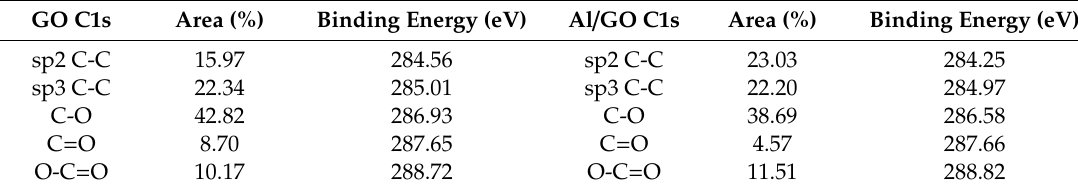
213.3 Figure 6. Mechanical properties of composites by weight fraction of GO: ( a ) density measured using Archimedes principles and ( b ) Vicker’s hardness. The addition of graphene is known to increase the hardness by providing resistance to deformation when the complex is under pressure. Graphene addition is directly affected by the degree of dispersion of graphene and the interfacial properties of the matrix and additives. In addition, graphene can improve the mechanical properties by generating grain refinement of Al. Therefore, it was confirmed that the GO content increased to 0.3 wt.% and a value of 129.33 MPa was measured for the hardness (Figure 6b). However, when the GO content increased to more than 0.4